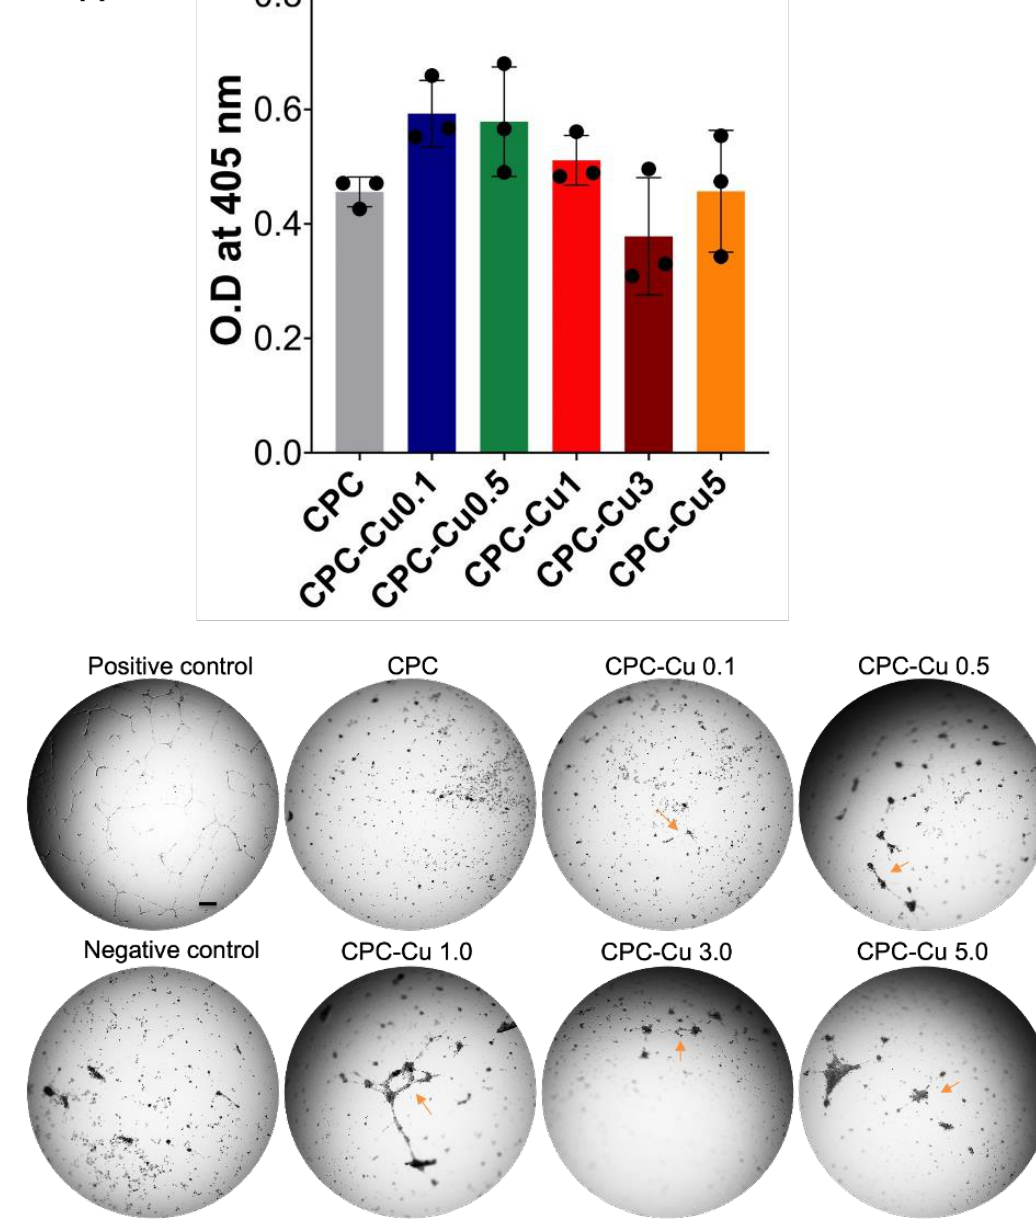
Figure 5. The multifunctionality of Cu loaded CPC scaffolds showing ( A ) alkaline phosphatase activity. The data are represented by mean ± standard deviation ( n = 3) and there is no significant difference between the groups and ( B ) angiogenic potential with arrows showing the tube formation on the extracellular matrix. The CPC-Cu 1 scaffolds showed increased tube formation compared to other Cu loaded CPC scaffolds.